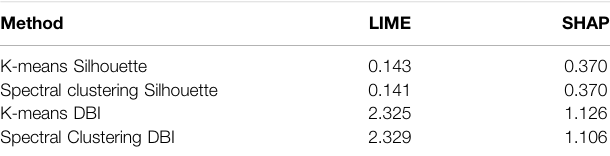
TABLE 1 | Clustering evaluation